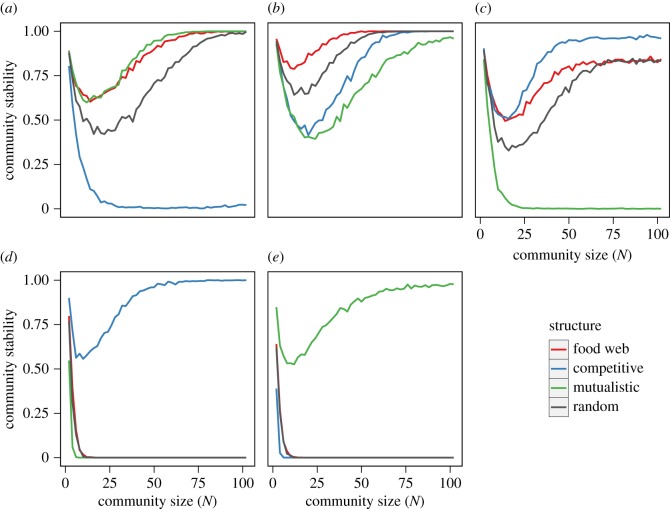
Numerically calculated stability of structured communities with density-dependence variation. Each coloured line represents the proportion of structured communities with stable equilibrium: red, blue, green and grey lines are the results of food-web-dominated communities ((p, c, m) = (0.4, 0.2, 0.2) for (a–c) and (0.7, 0.1, 0.1) for (d–e)), those of competition-dominated communities ((p, c, m) = (0.2, 0.4, 0.2) for (a–c) and (0.1, 0.7, 0.1) for (d–e)), those of mutualism-dominated communities ((p, c, m) = (0.2, 0.2, 0.4) for (a–c) and (0.1, 0.1, 0.7) for (d–e)) and those of random-dominated communities ((p, c, m) = (0.2, 0.2, 0.2) for (a–c) and (0.1, 0.1, 0.1) for (d–e)). The distributions of density dependence used were (a) βij = U(−0.7, −0.3) and δij = U(−0.3, 0.1); (b) βij = U(−0.4, 0.0) and δij = U(0.0, 0.4); (c) βij = U(−0.1, 0.3) and δij = U(0.3, 0.7); (d) βij = U(0.9, 1.3) and δij = U(0.8, 1.2); (e) βij = U(−1.2, −0.8) and δij = U(−1.3, −0.9). Other parameters: C = 1.0, smax = 2.0 and Xmax = 2.0.